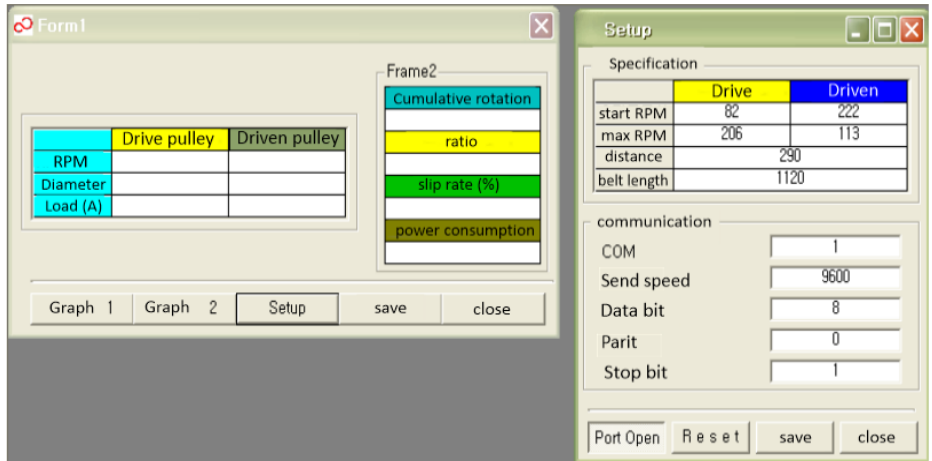
Figure 16. Main screen of computer output.